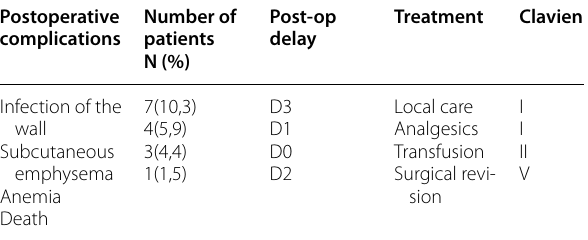
Table 2 Postoperative complications according to the Clavien– Dindo classification Postoperative Number of complications patients